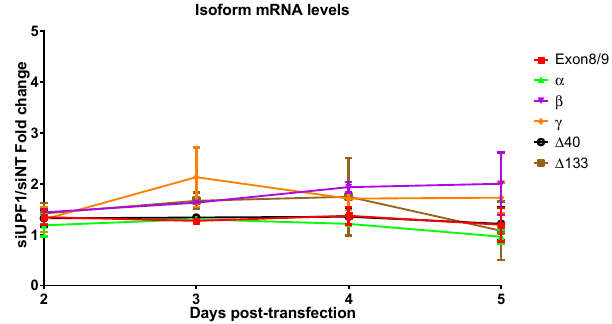
Figure A3. Summary RT-PCR analysis from two experiments (duplicated each) of p53 isoform mRNA expression following MCF7 transfection with siUPF1 or siNT at 48-, 72-, 96-, and 120 h. Cells were harvested at indicated time post-transfection. Results for siUPF1 are shown normalized to siNT. Taqman primers are the same as those in Figure 2B. Error bars represent Mean ± SD. For all RT-PCR studies, individual samples are run in triplicate.